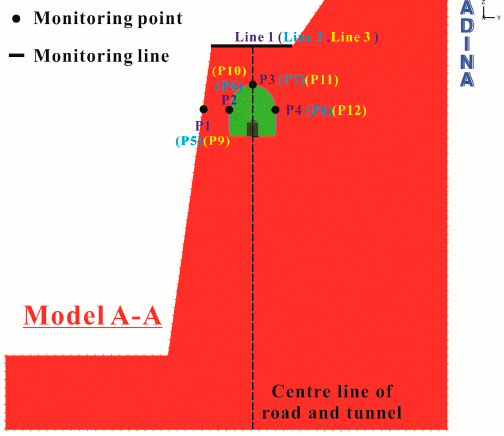
Figure 23. Schematic of in situ monitoring point locations.